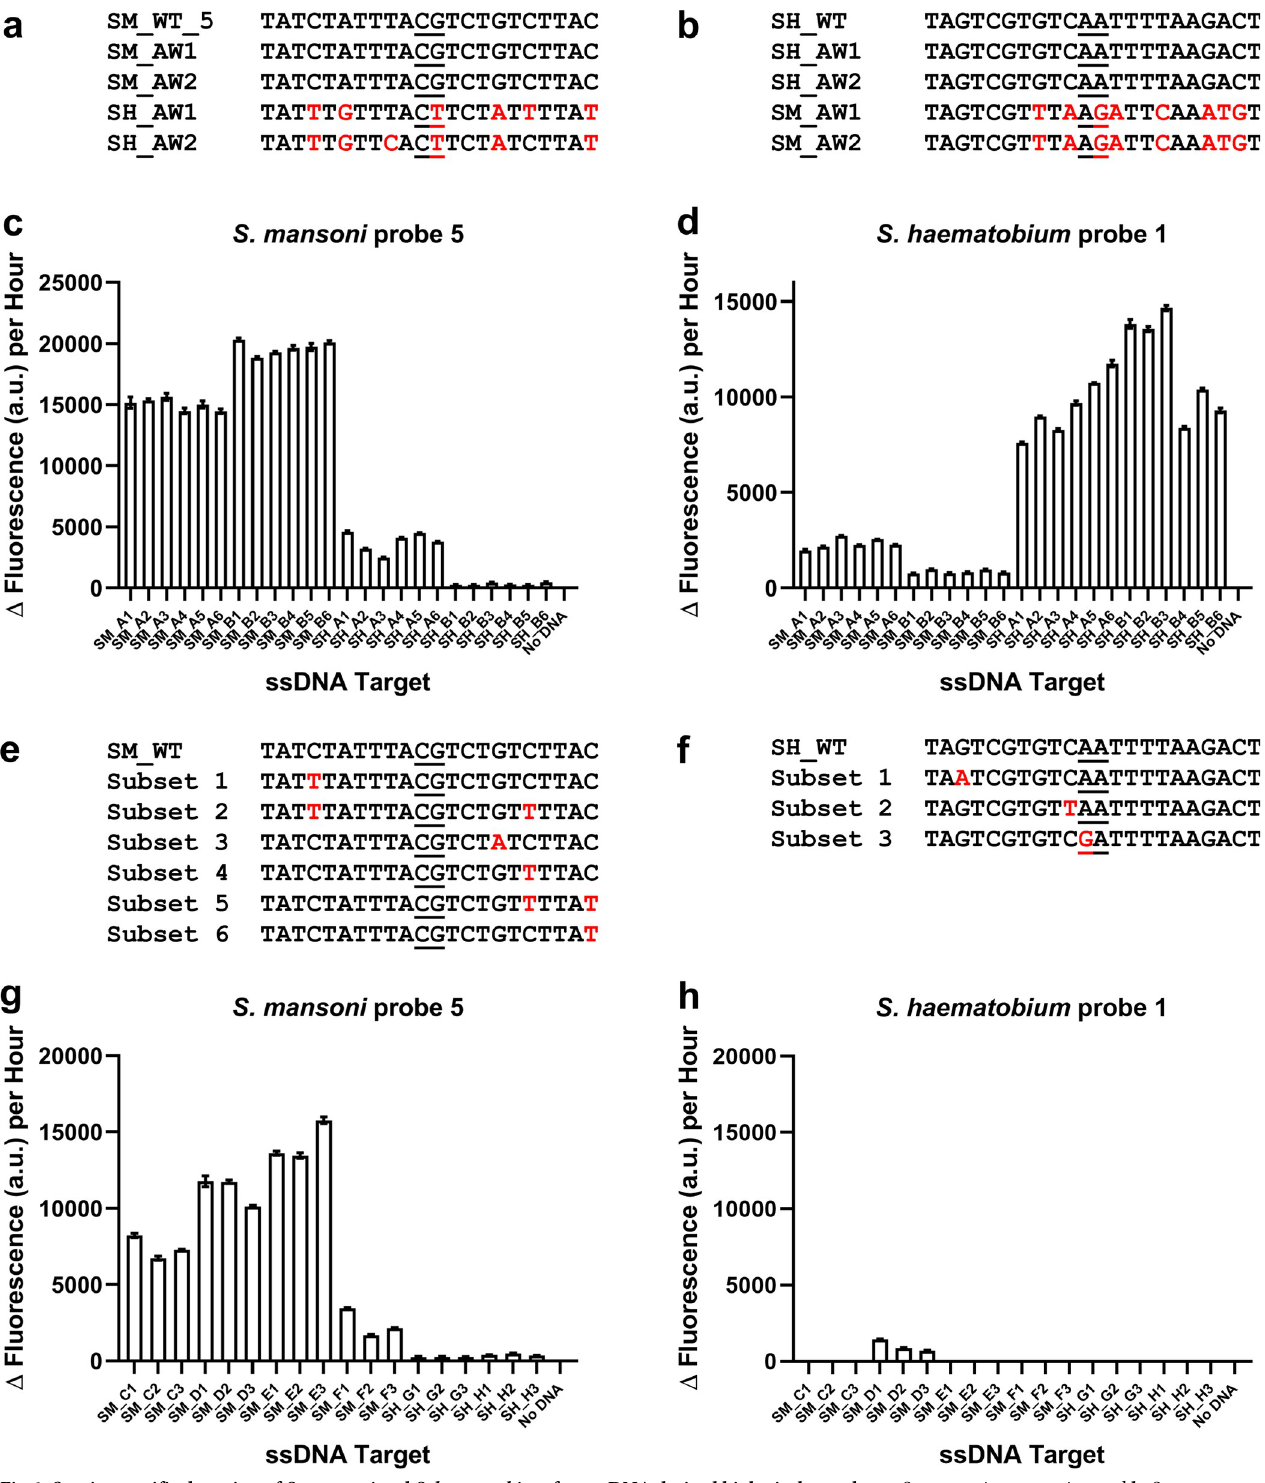
Fig 6. Species specific detection of S . mansoni and S . haematobium from gDNA derived biological samples. a , S . mansoni target region and b , S . haematobium target region and the corresponding regions from the four adult worm samples tested: S . mansoni adult worms 1 and 2 (SM_AW1 and SM_AW2 respectively) and S . haematobium adult worms 1 and 2 (SH_AW1 and SH_AW2 respectively). The differences between the target region and the corresponding regions of the adult worms are indicated in red. The probe ligation junctions are underlined. c , S . mansoni probe set 5 can differentiate between ssDNA